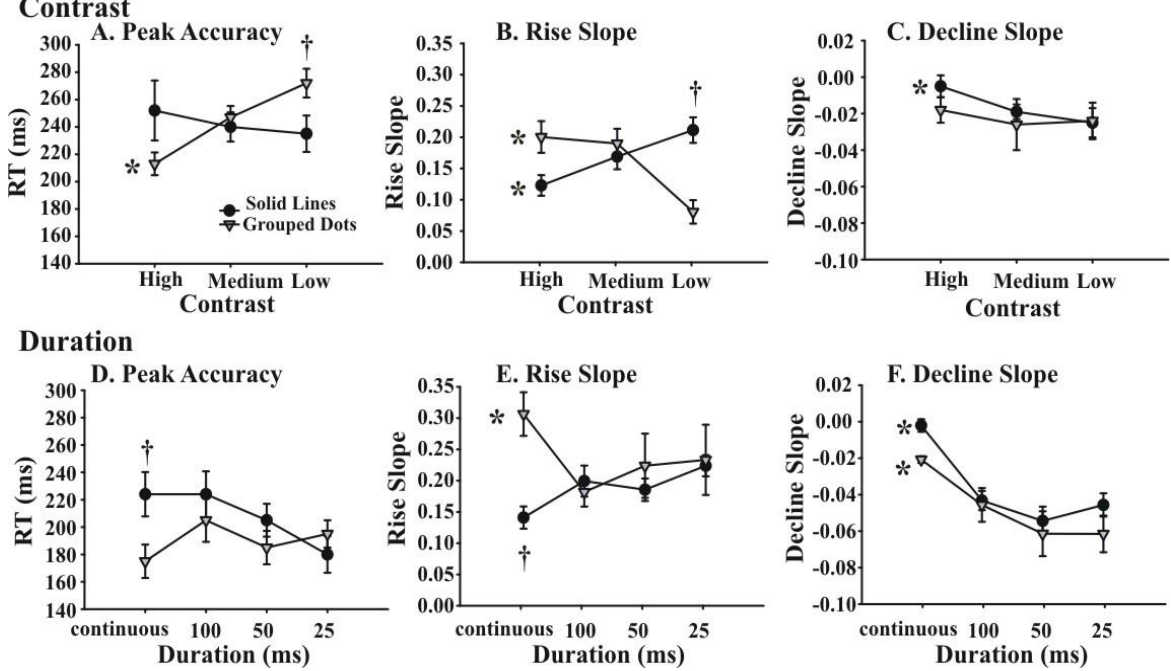
Figure 5 . Characteristics of accuracy for the stimulus contrast (A - C) and stimulus duration (D - F) conditions. A and D : RT at peak accuracy; B and E : slope representing progressive increase in accuracy before peak; C and F : slope representing decline in accuracy following peak. Asterisks represent significant differences across levels of contrast or duration, and † represent significant differences between lines and dots conditions. Error bars represent